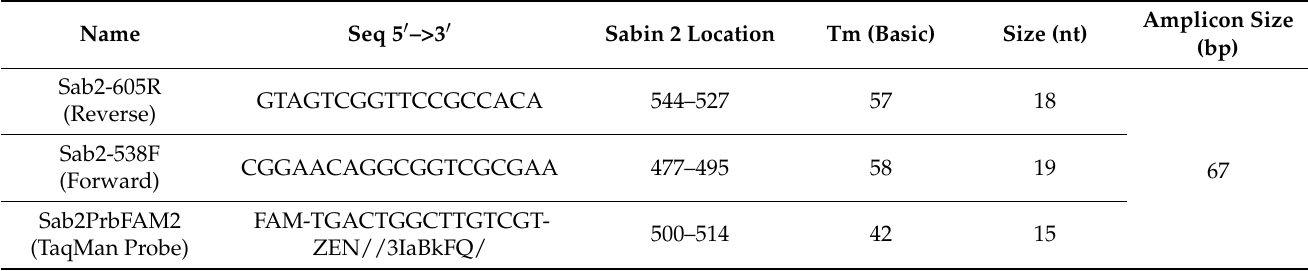
Table 1. Primers and TaqMan probe for detection and quantitation of Sabin 2 virus in